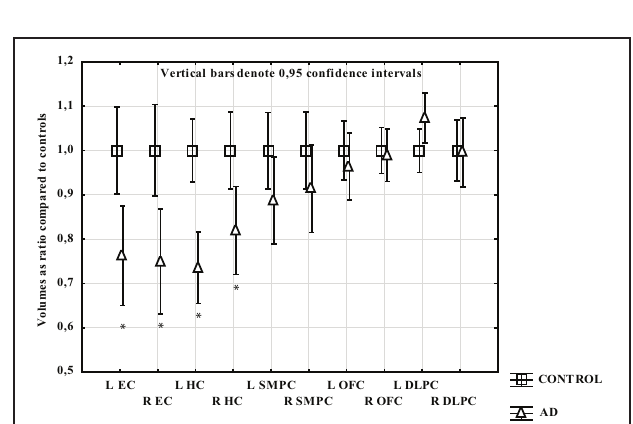
FIGURE 4 | The volume of measured region in SD expressed as a ratio of CTL volume. CTL volume is set to 1. X-axis denotes the included regions: EC, entorhinal cortex; HC, hippocampus; OFC, orbitofrontal cortex; SMPC, subcallosal medial prefrontal cortex; DLPFC, dorsolateral prefrontal cortex. ∗ p < 0 . 01.